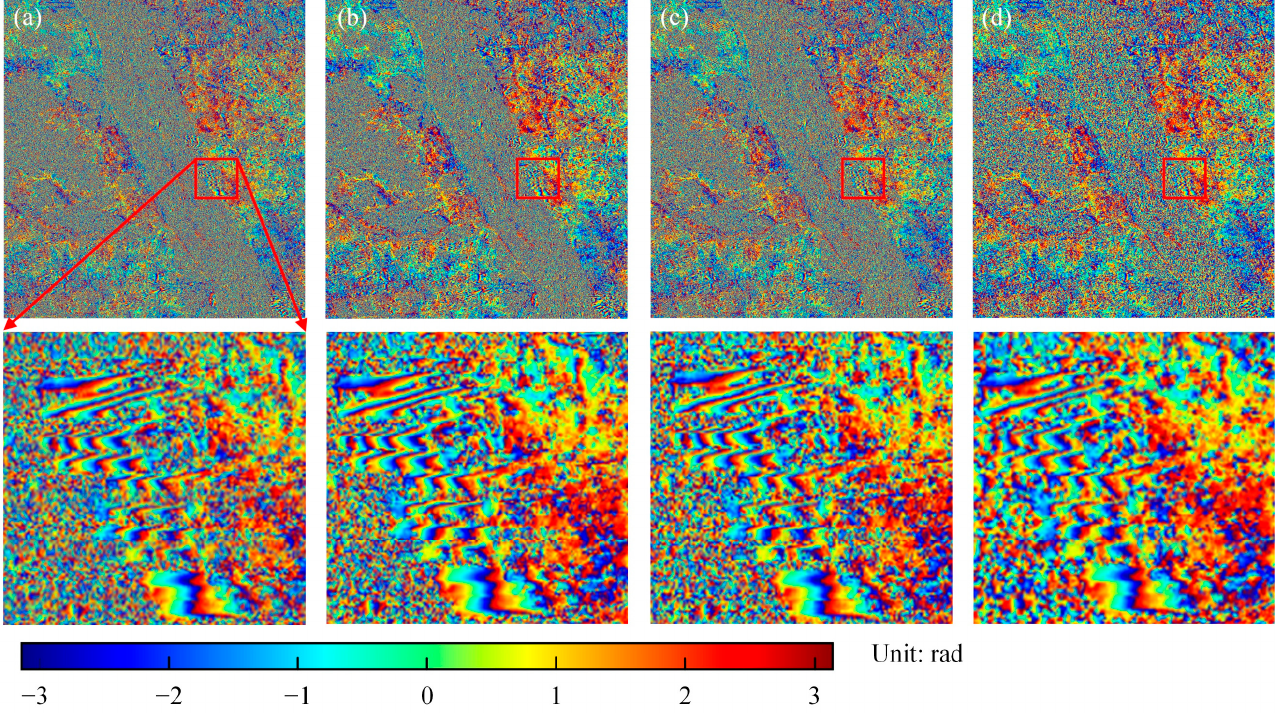
Figure 5. Contrast of differential interferograms (11 June 2016–8 February 2016). ( a ) Original interferogram. ( b ) Goldstein phase optimization. ( c ) Gaussian-weighted phase optimization. ( d ) Adaptive window phase optimization.